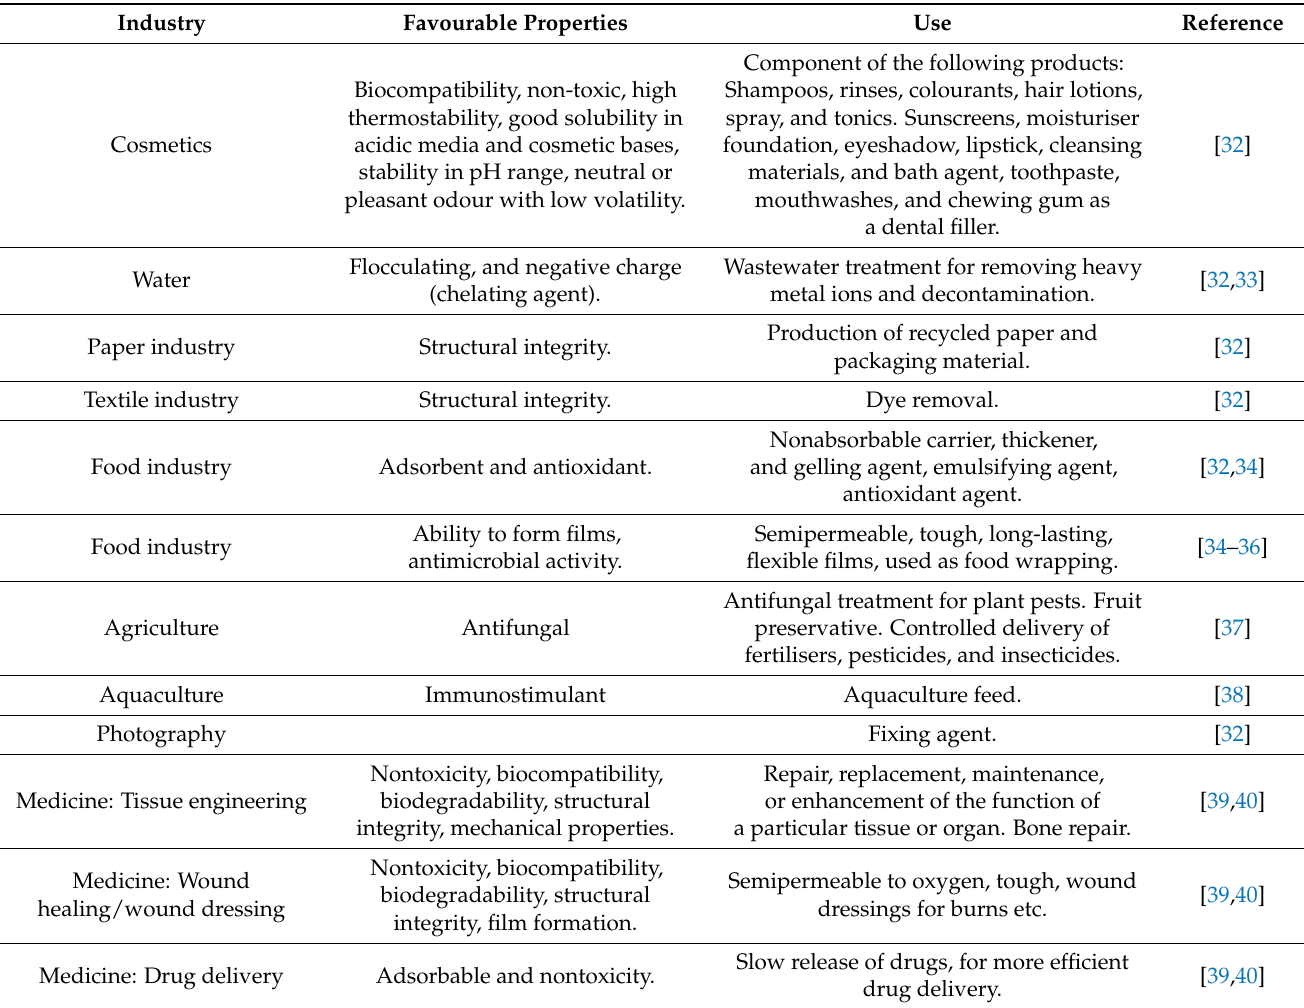
Table 5. Properties of chitin/chitin derivatives and applications in different industries (reviewed extensively in [31] and summarised